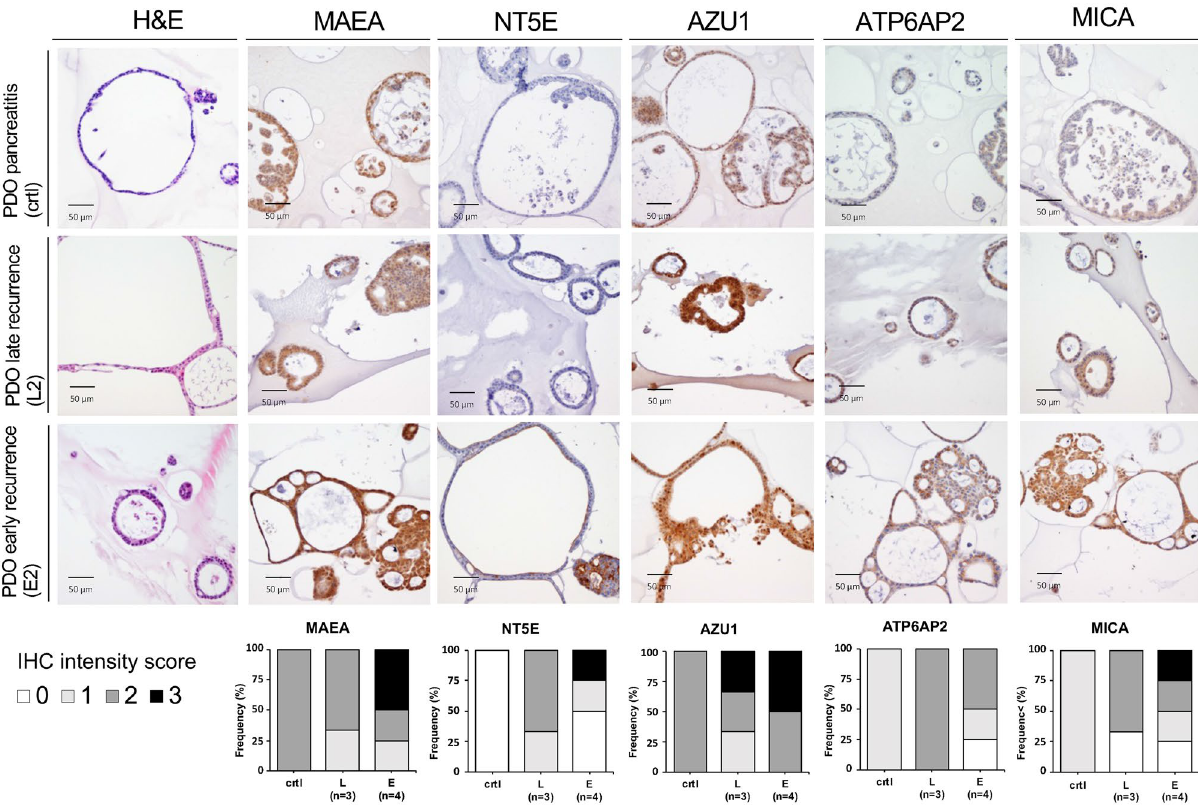
Figure 4. Immunohistochemistry staining of PDAC organoid cultures for MAEA, NT5E, AZU1, ATP6AP2 and MICA. The same organoid cultures as in Fig. 3 were analyzed. Brown color represents a positive staining. Staining intensity was semi-quantitatively scored as: 0 (negative), 1 (weak), 2 (moderate), 3 (strong) and is shown in the bottom panels as stacked bar graphs. For representation we selected organoid culture L2 for late recurrence, E2 for early recurrence and the non-tumor chronic pancreatitis organoid line as control.